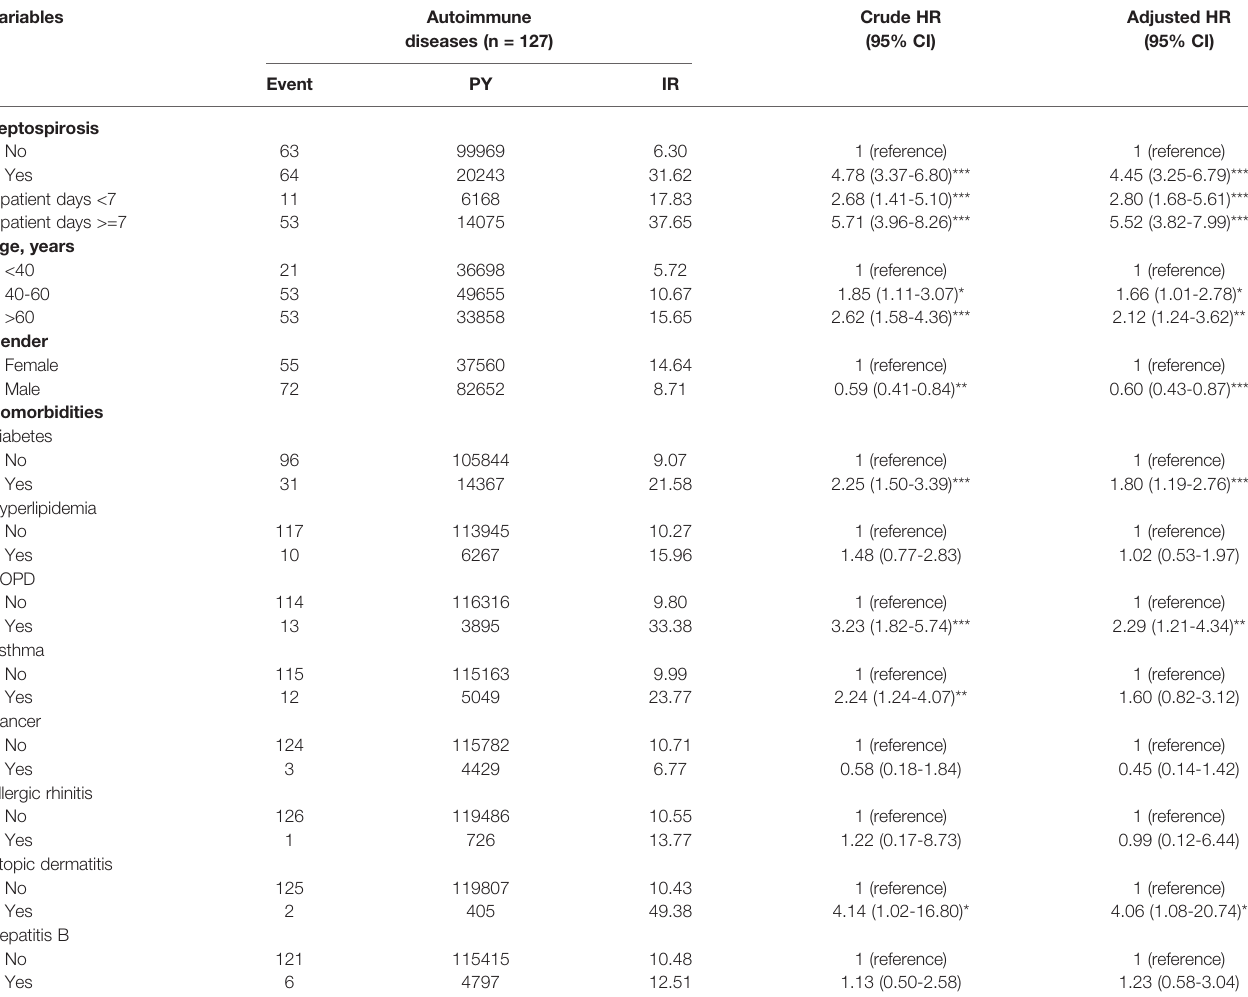
TABLE 2 | The incidence and HRs for risk of major autoimmune diseases (ADs).